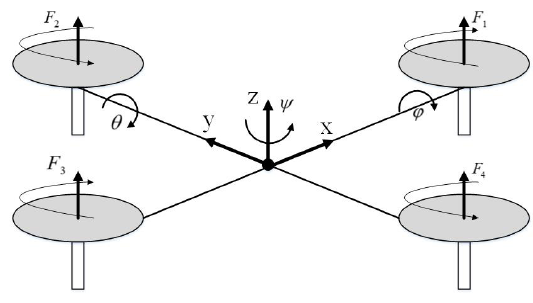
Figure 1. The structure of the quadrotor